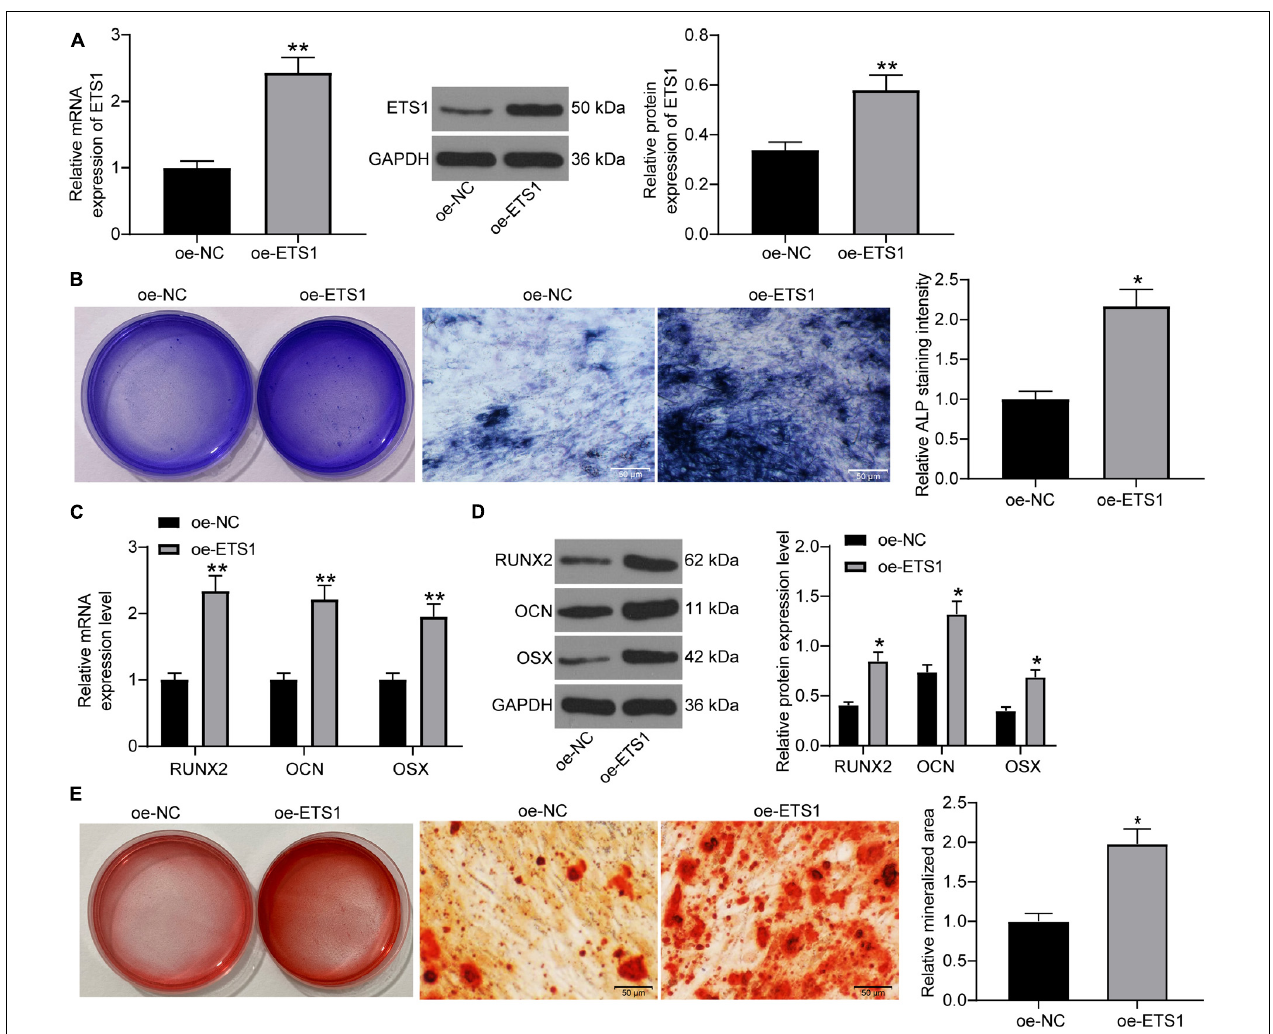
FIGURE 2 | Overexpression of ETS1 promotes osteogenic differentiation of MC3T3-E1 cells. (A) Transfection efficacy of oe-ETS1 in MC3T3-E1 cells determined by RT-qPCR and western blot analysis (unpaired t -test, ** p < 0.01). (B) After 7 days of osteogenic differentiation, the ALP expression in cells determined by ALP staining (osteogenic differentiation) (unpaired t -test, * p < 0.05). (C,D) mRNA (C) and protein (D) expression of OCN, OSX, and RUNX2 in cells determined by RT-qPCR and western blot analysis, respectively (two-way ANOVA, * p < 0.05; ** p < 0.01). (E) ALP concentration in cells measured by ALP staining (unpaired t -test, * p <